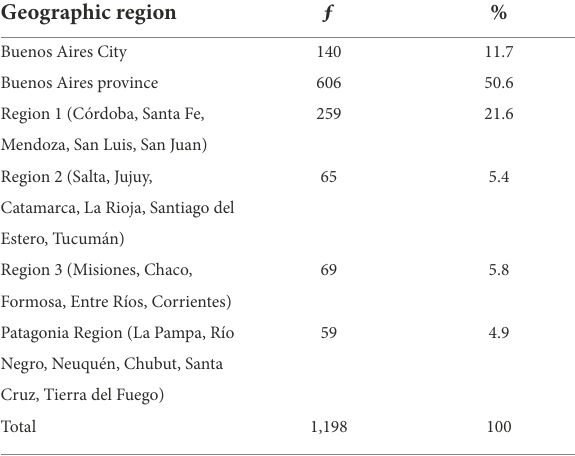
TABLE 1 Distribution of participants by geographic